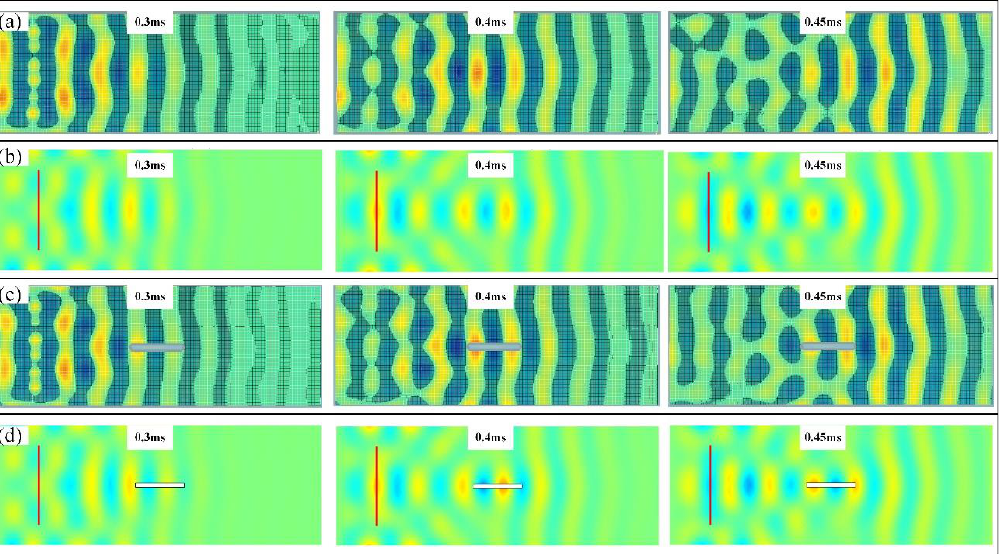
Figure 13. Instantaneous wave field under the linear excitations: ( a ) Experimental results of the intact plate; ( b ) semi-analytical results of the intact plate; ( c ) experimental results of the damaged plate; ( d ) semi-analytical results of the damaged plate.